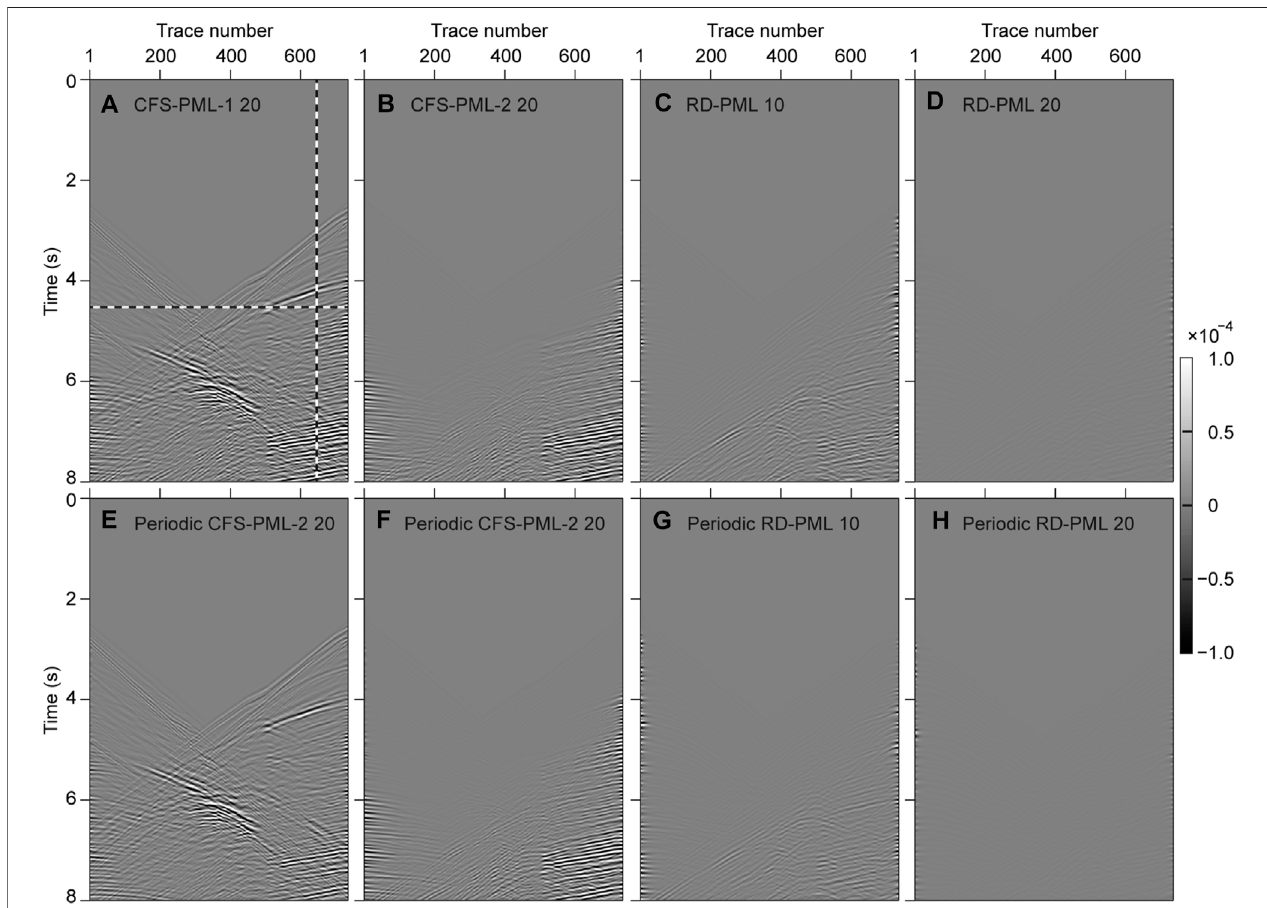
FIGURE 11 | Wave fi eld difference between the shot records of different types of PML with the reference shot records that shown in Figure 10B . (A) , (B) , (C) , and (D) are the wave fi eld difference between the shot records of 20-layer CFS-PML-1, 20-layer CFS-PML-2, 10-layer RD-PML, and 20-layer RD-PML with the theoretical records,respectively. (E) , (F) , (G) ,and (H) arethewave fi elddifferencethattheshotrecordsusingperiodicboundariesforthecorrespondingtypesofPMLin (A) , (B) , (C) , and (D) , respectively.